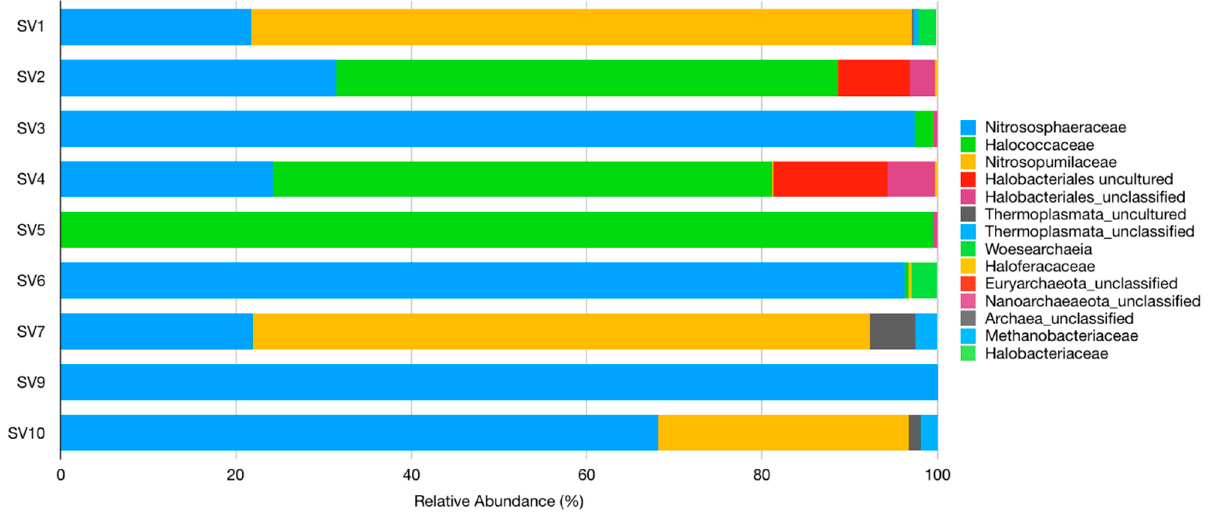
Figure 3. ( A ) Principal component analysis (PCA) and ( B ) neighbor − joining dendrogram based on the Euclidean distance for domain Bacteria Operational Taxonomic Units (OTU) profiles. Biofilm classification was used as an environmental variable for PCA and is displayed with each sample designation in the dendrogram (GbS: Green biofilm with visible salt efflorescence; Gb: Green biofilm; DGbS: Dark and green biofilm with visible salt efflorescence; Bd: Black discoloration). 3.3.1. Domain Bacteria For domain Bacteria, a direct correlation between specific population profiles (from each sample) and biodeterioration patterns was not verified consistently. Except for sam- ples SV1, SV7, and SV5 that were distant from the remaining samples, all others were clustered together, regardless of the degradation pattern where they were collected from. Samples SV1 and SV7 were collected in different chapels but clustered together in the PCA and Euclidean similarity dendrogram, indicating a similar composition and distribution. Sample SV5 represented the only sample classified as “black discoloration with salt